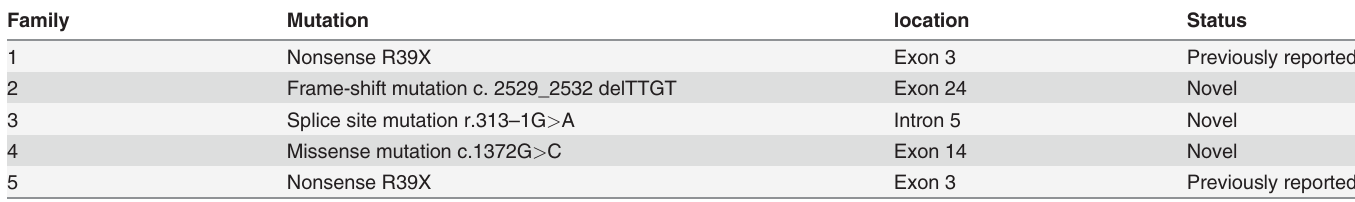
Table 2. Identi fi cation of three novel and one recurrent mutation in ATP2C1 in Lebanese families with Hailey-Hailey disease.